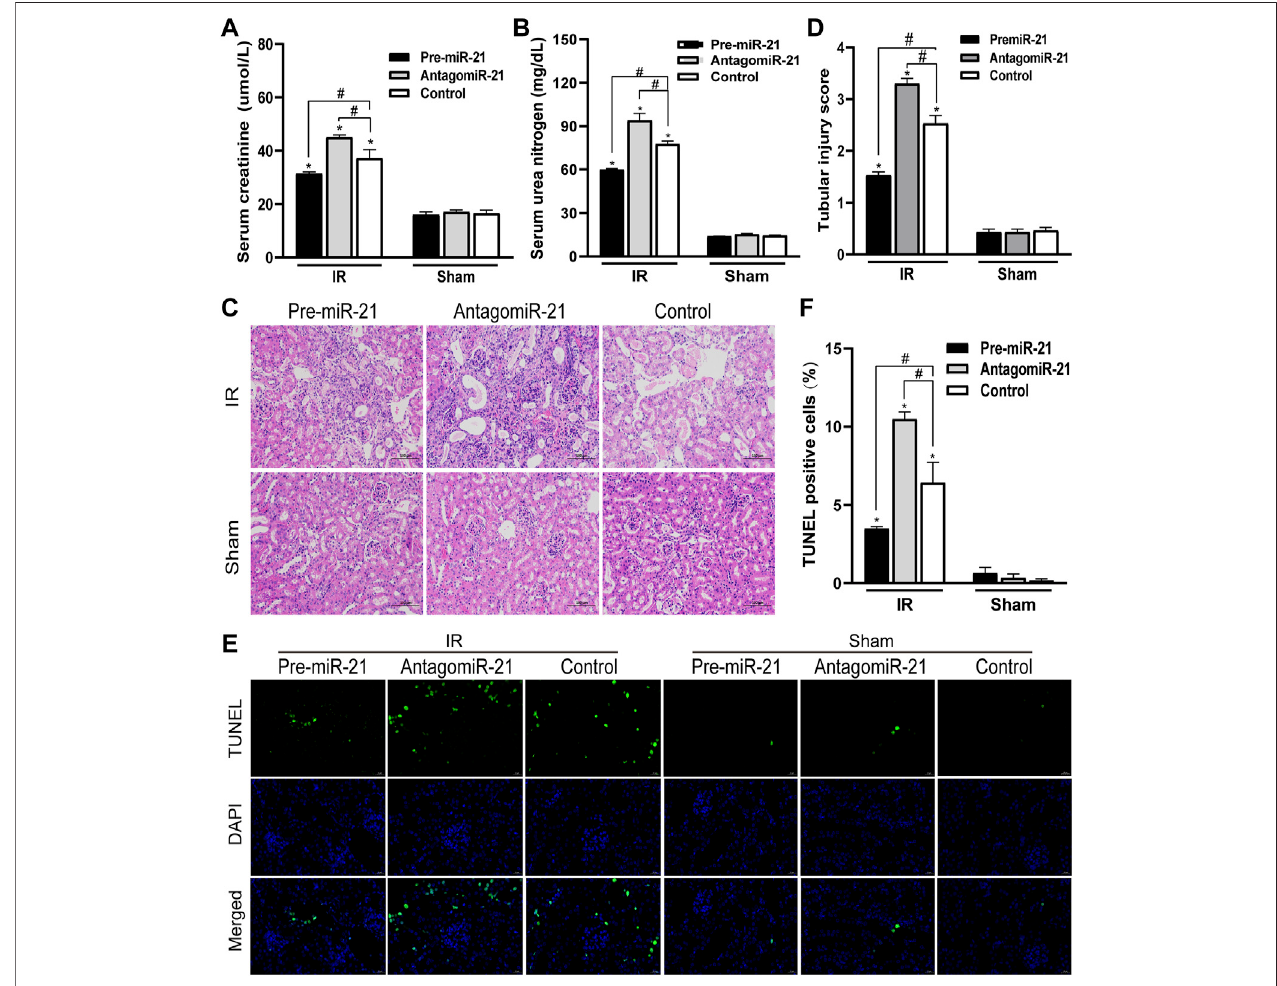
FIGURE5| MiR-21 amelioratedthe decline ofrenal functionand tubulardamage in mice. (A,B) pre-miR-21 reduces serum creatinine (A) and serum urea nitrogen (A) levels after renal ischemia-perfusion, while antagomiR-21 intervention aggravated the decline of renal function. (C) HE staining of renal tissue in each group (original magni fi cation ×200). (D) Corresponding renal tissue pathological damage score. (E) Representative photograph for TUNEL staining section of renal tubular epithelial cells (green) in each group. Original magni fi cation: ×400. Scale bar: 20 µm. (F) Quantitative evaluation of TUNEL-positive cells in renal tissue. Data displayed are mean ± SEM ( n > 5). Compared with sham operation group, * p < 0.05. Compared with Control + IR group, # p <